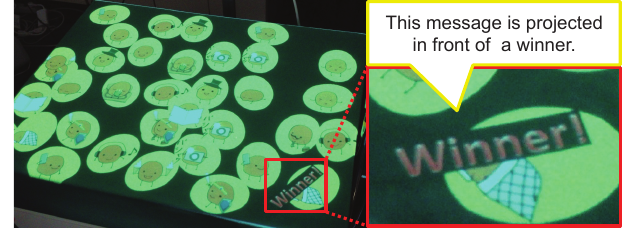
Figure 8. Message to celebrate the winner.